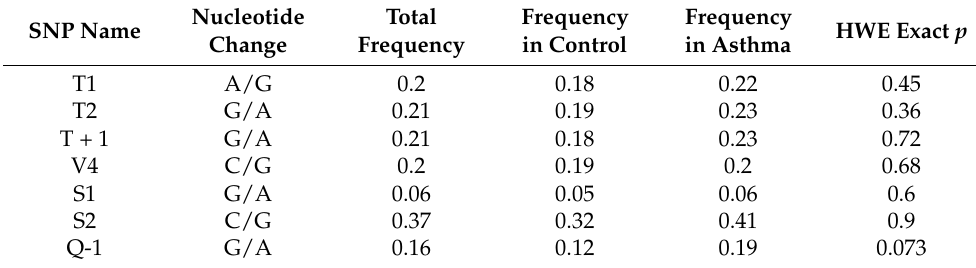
Table 2. Minor allele frequencies and their association analyses in adults.